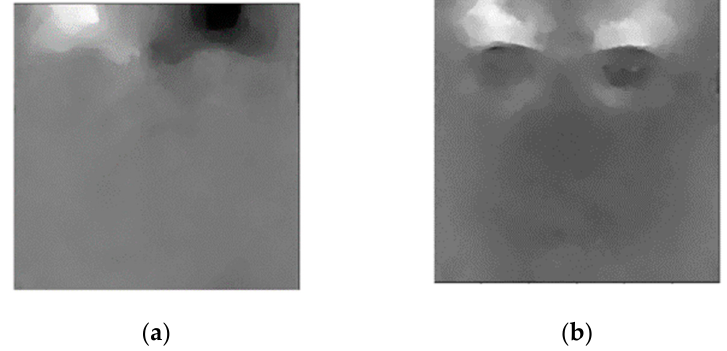
Figure 4. ( a ) Horizontal optical flow component; ( b ) vertical optical flow component.